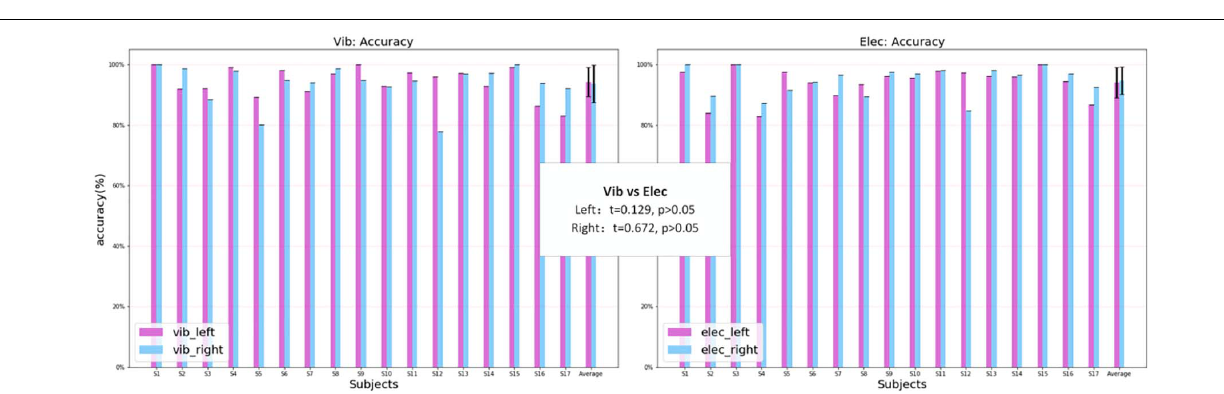
FIGURE 11 | The classification accuracy and ITR of the two stimulation patterns over all subjects.